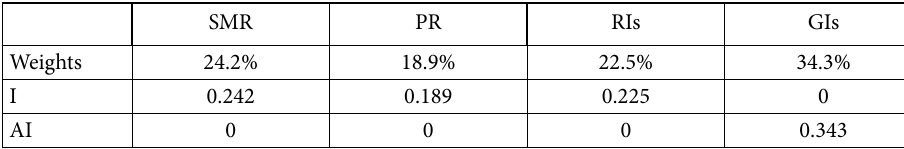
Table 4. Weights of variables (source: own calculation, 2022) SMR PR RIs GIs